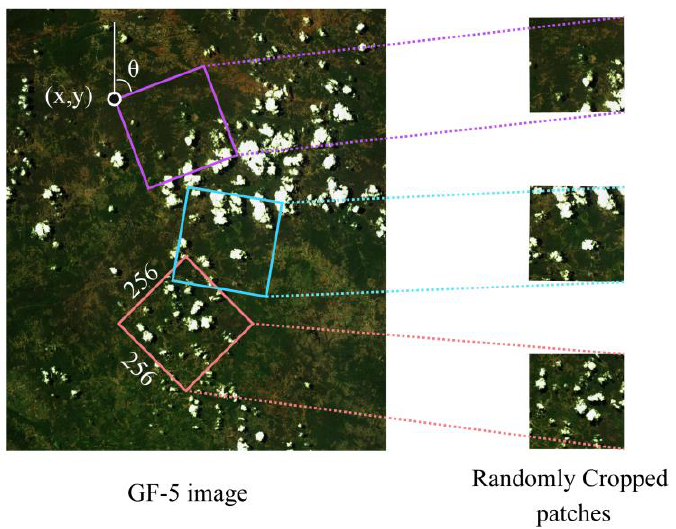
Figure 7. Random cropping strategy for the dataset.